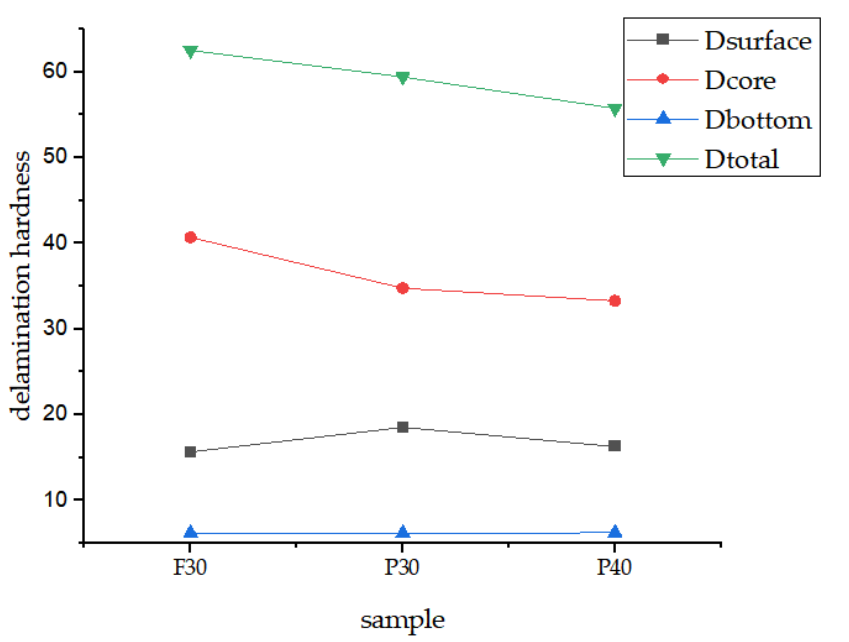
Figure 4. The mean hardness of the mattresses evaluated in this study (cushion layer). Table 4. ANOVA results for K and